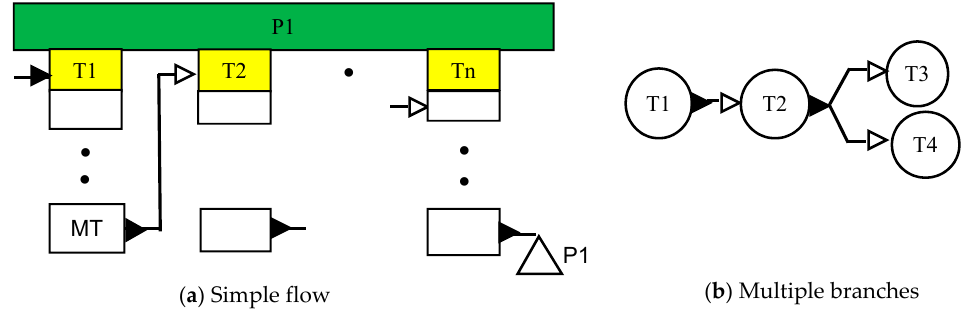
Figure 7. Front-end driven recipe patterns with single independent task.